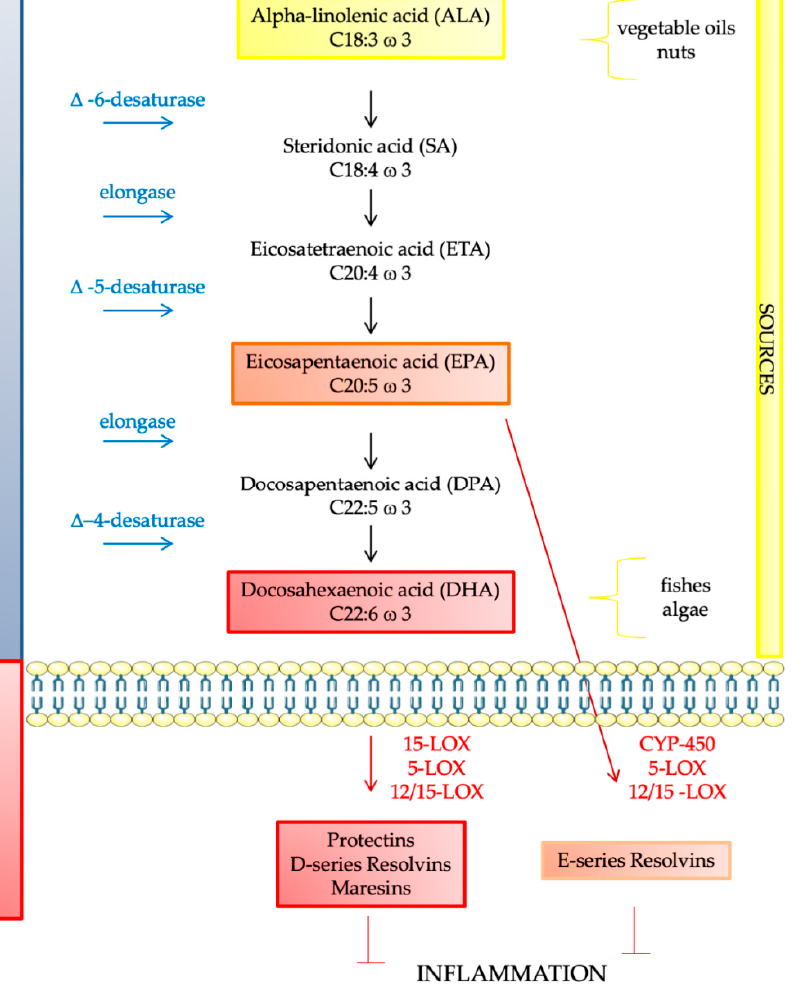
Figure 1. Endogenous synthesis of omega-3 polyunsaturated fatty acids and their involvement in inflammation. 15-LOX: 15-Lipoxygenase, 5-LOX: 5-Lipoxygenase, 12/15-LOX: 12/15 Lipoxygenase, CYP-450: Cytochrome P450. Table 2. Amount of α -linolenic acid (ALA), eicosapentaenoic acid (EPA), and docosahexaenoic acid (DHA).